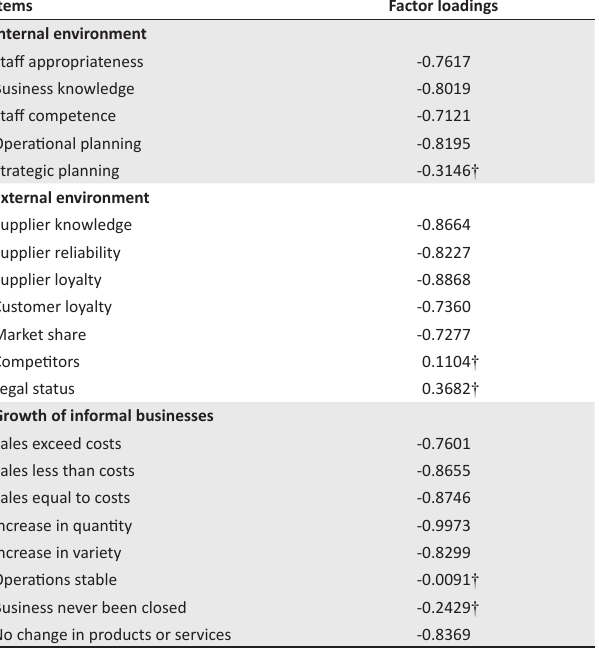
TABLE 1: Factor loadings and items of